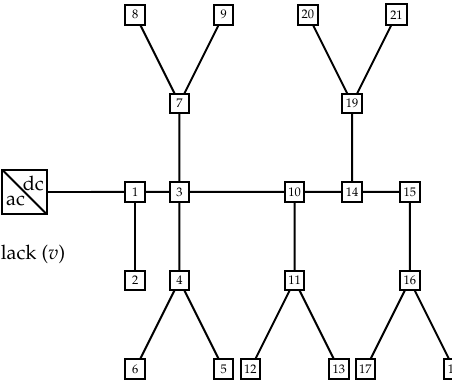
Figure 2. Single-diagram of the 21-bus grid.